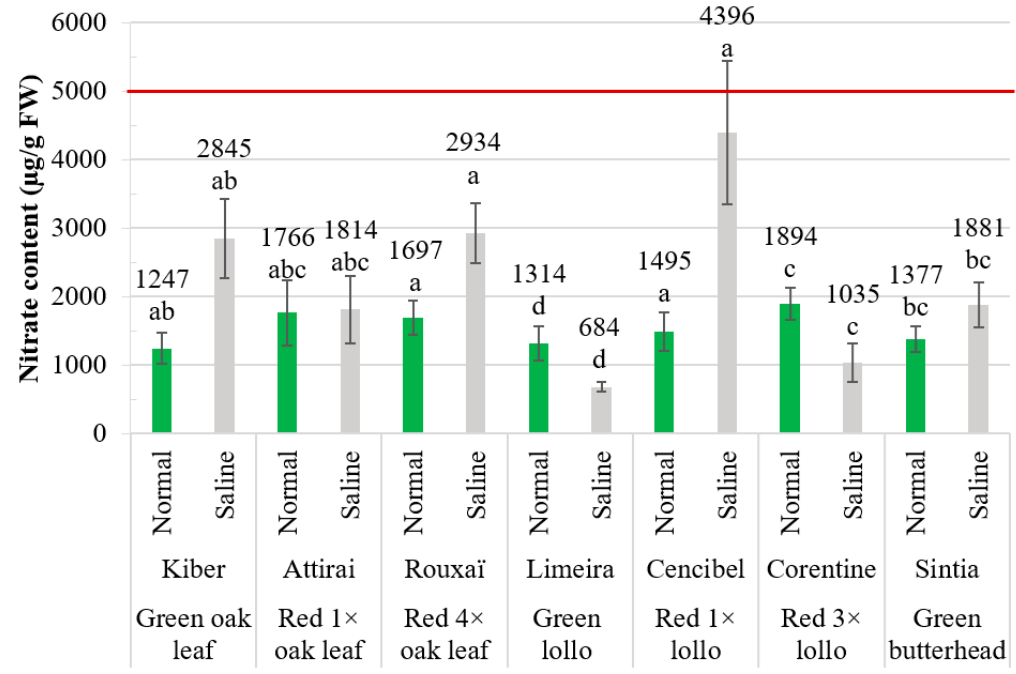
Figure 3. Nitrate content (µg/g FW) of different cultivars of lettuce grown in saline and normal conditions. Different letters indicate significant differences among the treatments at p < 0.05 by Tukey-Kramer’s test.